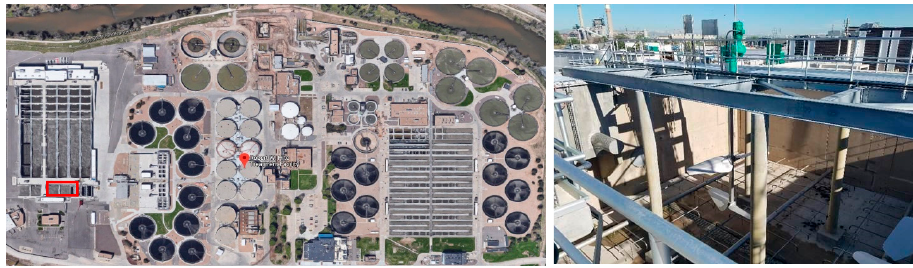
Figure 5. Photo of the ANITA Mox reactor in Denver retrofitted into an existing RAS reaeration tank.